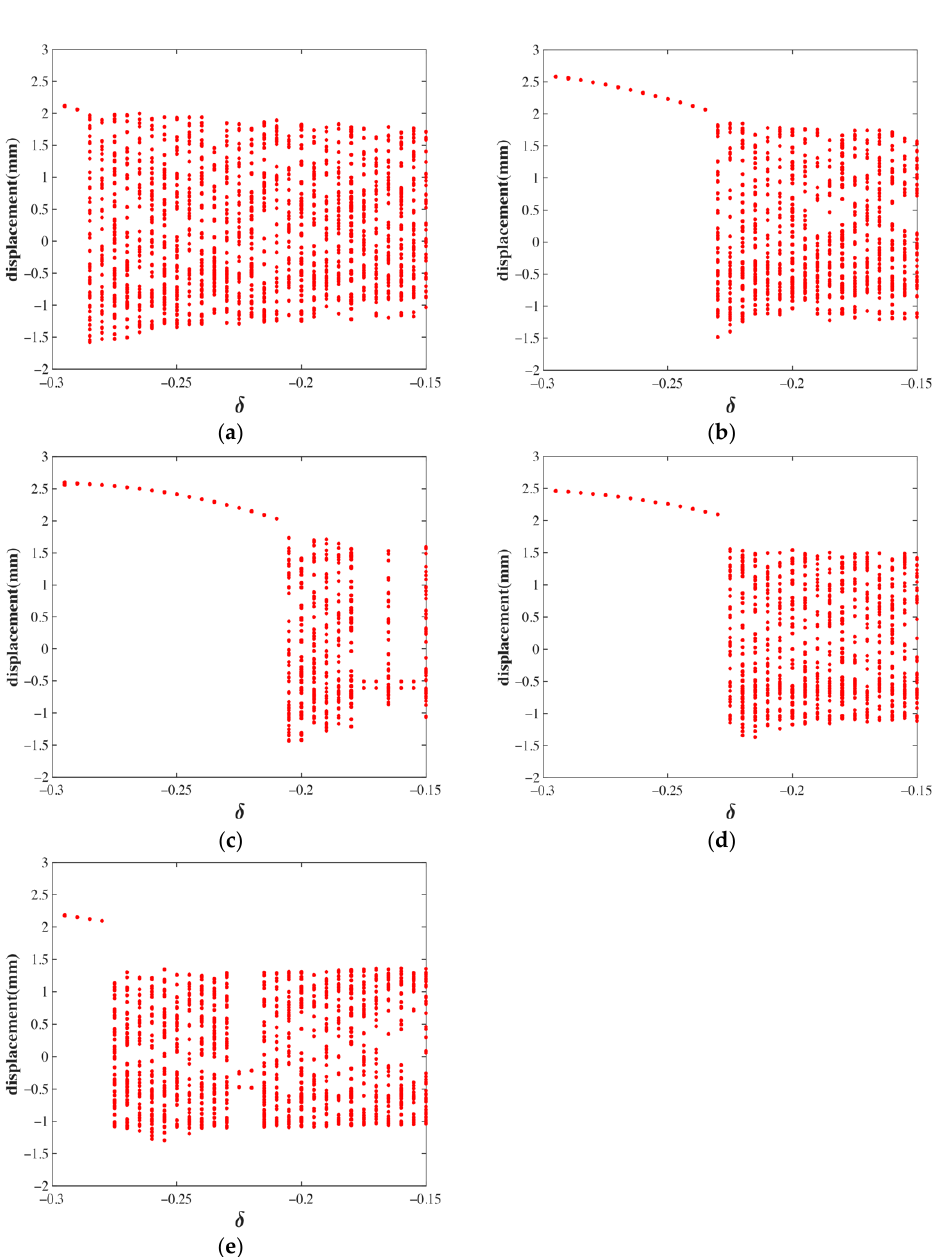
Figure 18. Local bifurcation diagram of the system with δ at different orders α : ( a ) α = 0.55; ( b ) α = 0.75; ( c ) α = 1; ( d ) α = 1.25; ( e ) α = 1.45.